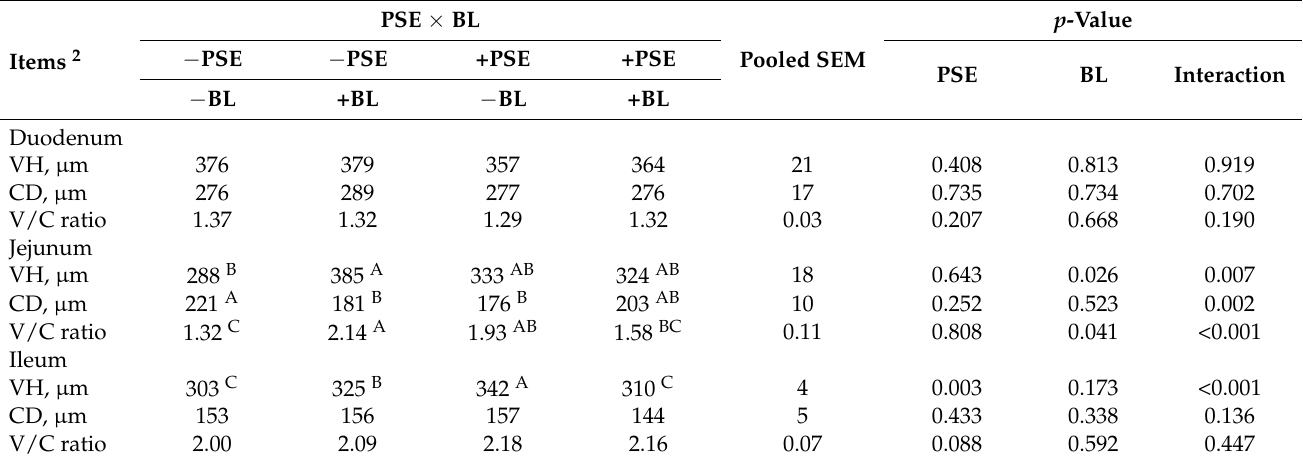
Table 4. Effects of BL and PSE on intestinal mucosa morphology of weaned piglets 1 .